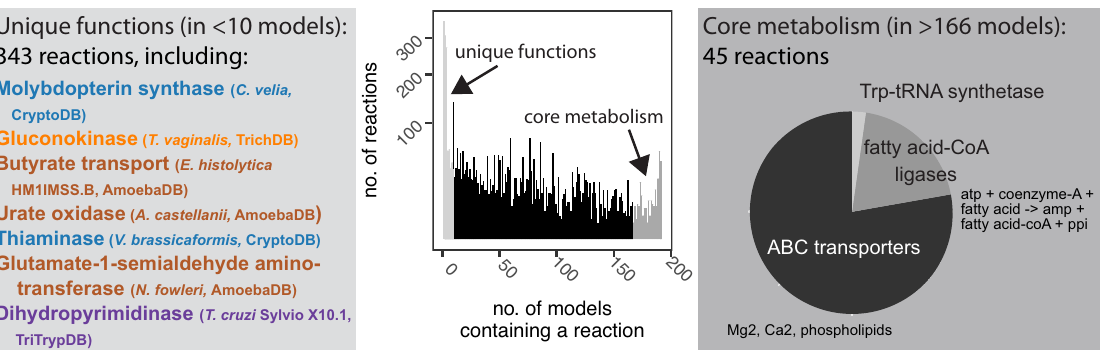
Fig 4. Reaction frequency ranges from unique to core metabolism. Reconstructions help identify rare metabolic functions ( light grey box and on histogram, in fewer than 10 reconstructions) and core parasite metabolism ( dark grey box and on histogram, in more than 166 reconstructions). Example rare reactions include seven metabolic reactions that are found in only one reconstruction. Of the 45 reactions found in all reconstructions (core metabolism), most reactions correspond to ABC transporter functions for ions or phospholipids. One reaction corresponds with a tRNA synthetase and the remaining correspond to fatty acid-CoA ligases for various fatty acids.